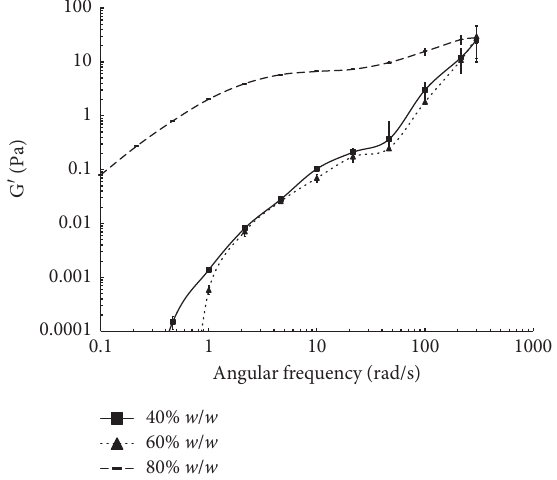
Figure 1: Frequency sweep of 40% w / w , 60% w / w , and 80% w / w O/ W emulsions. A plateau or rubbery behavior zone is not present at concentrations lower than 60% w / w and is enhanced beyond the threshold. This is indicative of the difference in the “liquid-like” nature of low-concentration emulsions as opposed to the “solid- like” nature of highly concentrated